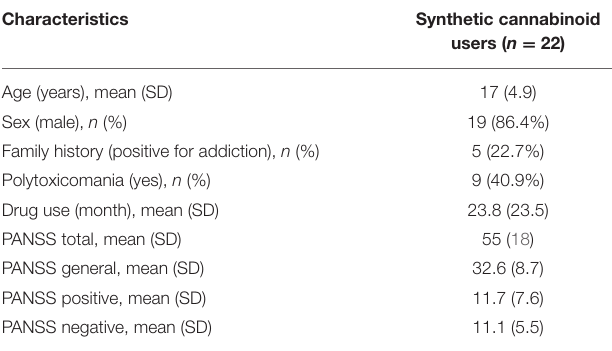
TABLE 1 | Characteristics of